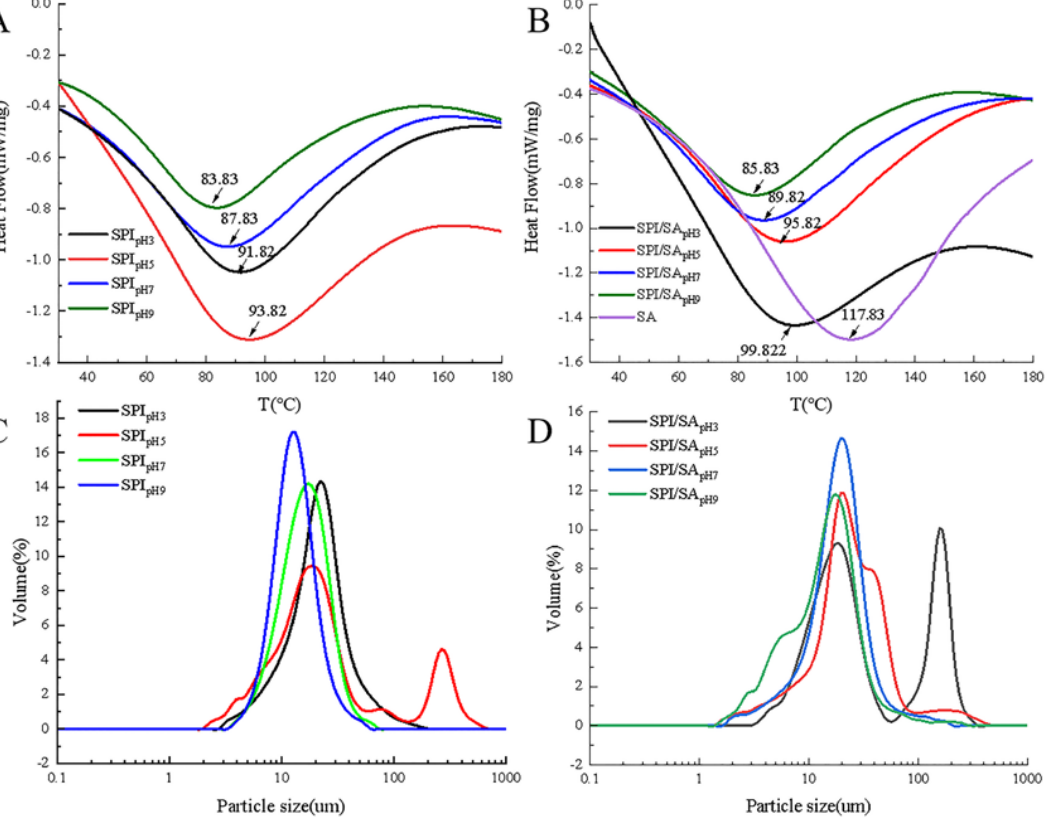
Figure 3. Thermal stability ( A , B ) and particle size ( C , D ) of SPI and SPI/SA microparticles at different pH values.